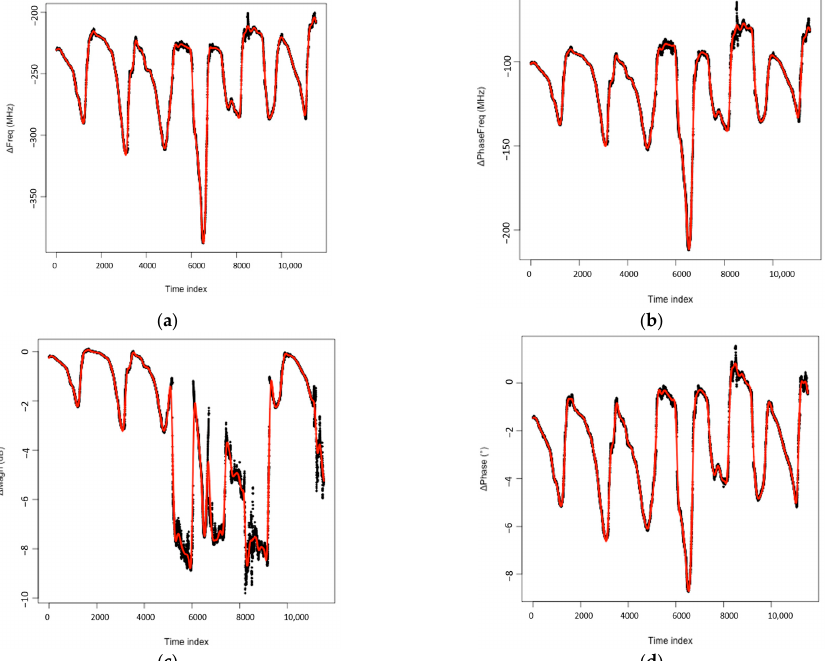
Figure 10. Sensor differential outputs ( a ) Δ Freq, ( b ) Δ Phasefreq, ( c ) Δ Magn and ( d ) Δ Phase. The black and red lines show the raw and filtered data respectively.